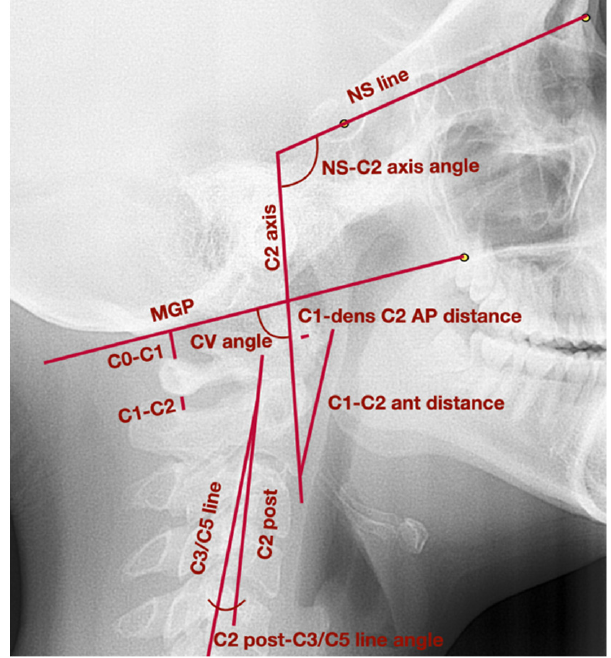
Figure 2. Lateral cephalogram with marked points, lines, and angles presented in Table 1 used to assess head position, cervical vertebrae, and functional spaces. AP—anteroposterior; CV an-